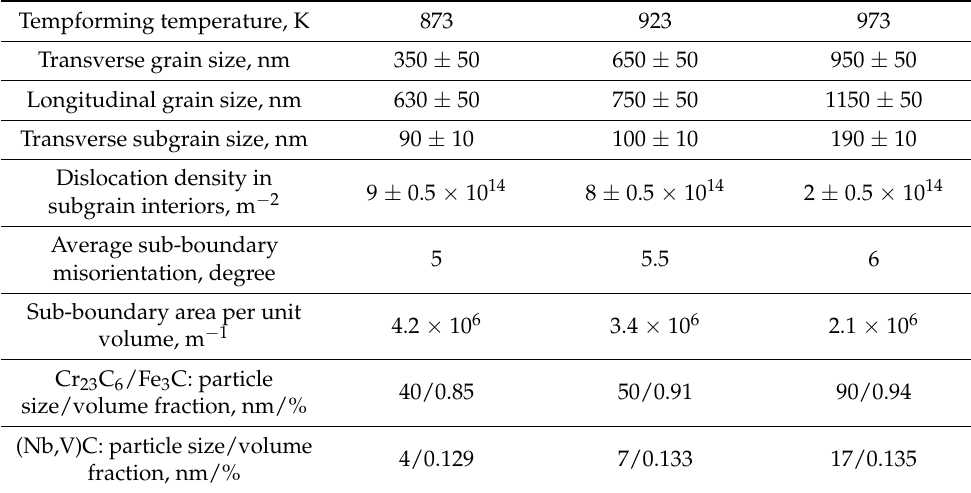
Table 1. Some microstructural parameters of an HSLA steel after tempforming.